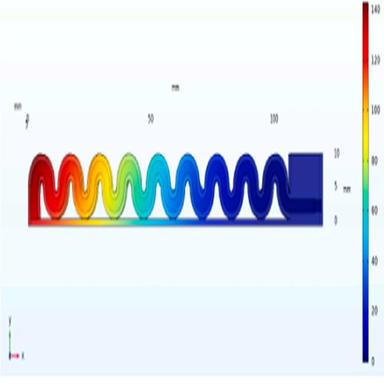
Finite element analysis of total displacement under a pressure of 25 psi.